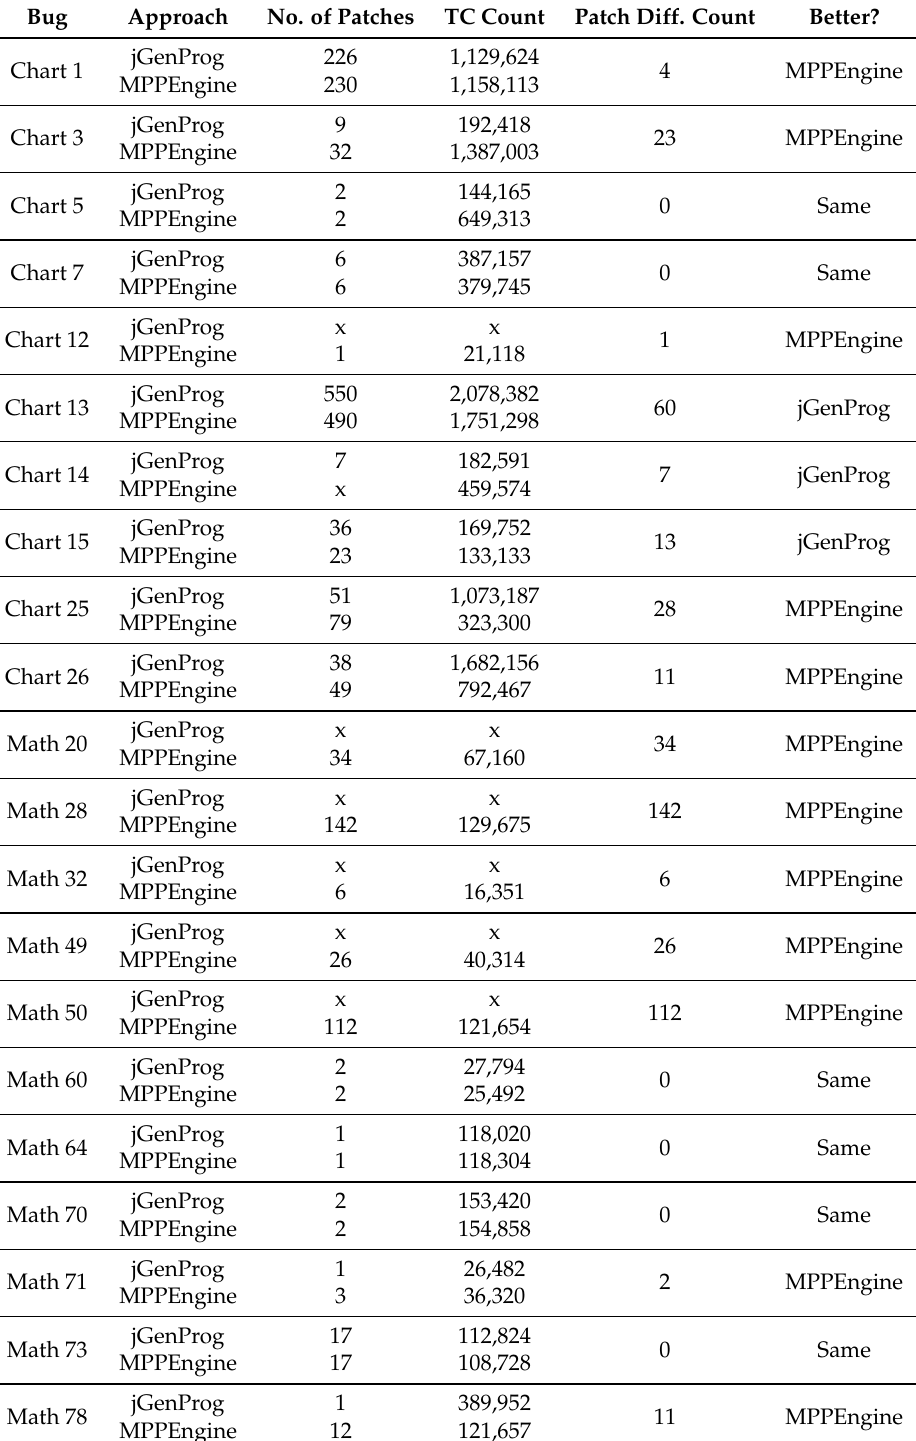
Table 3. Experiment results of jGenProg and MPPEngine on Defects4j